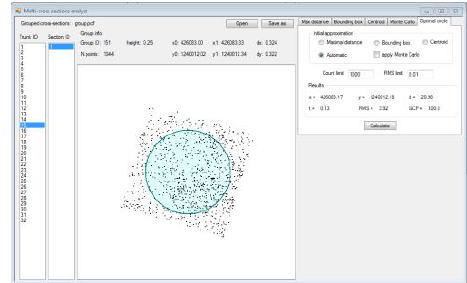
Figure 5. Example of the reference object position